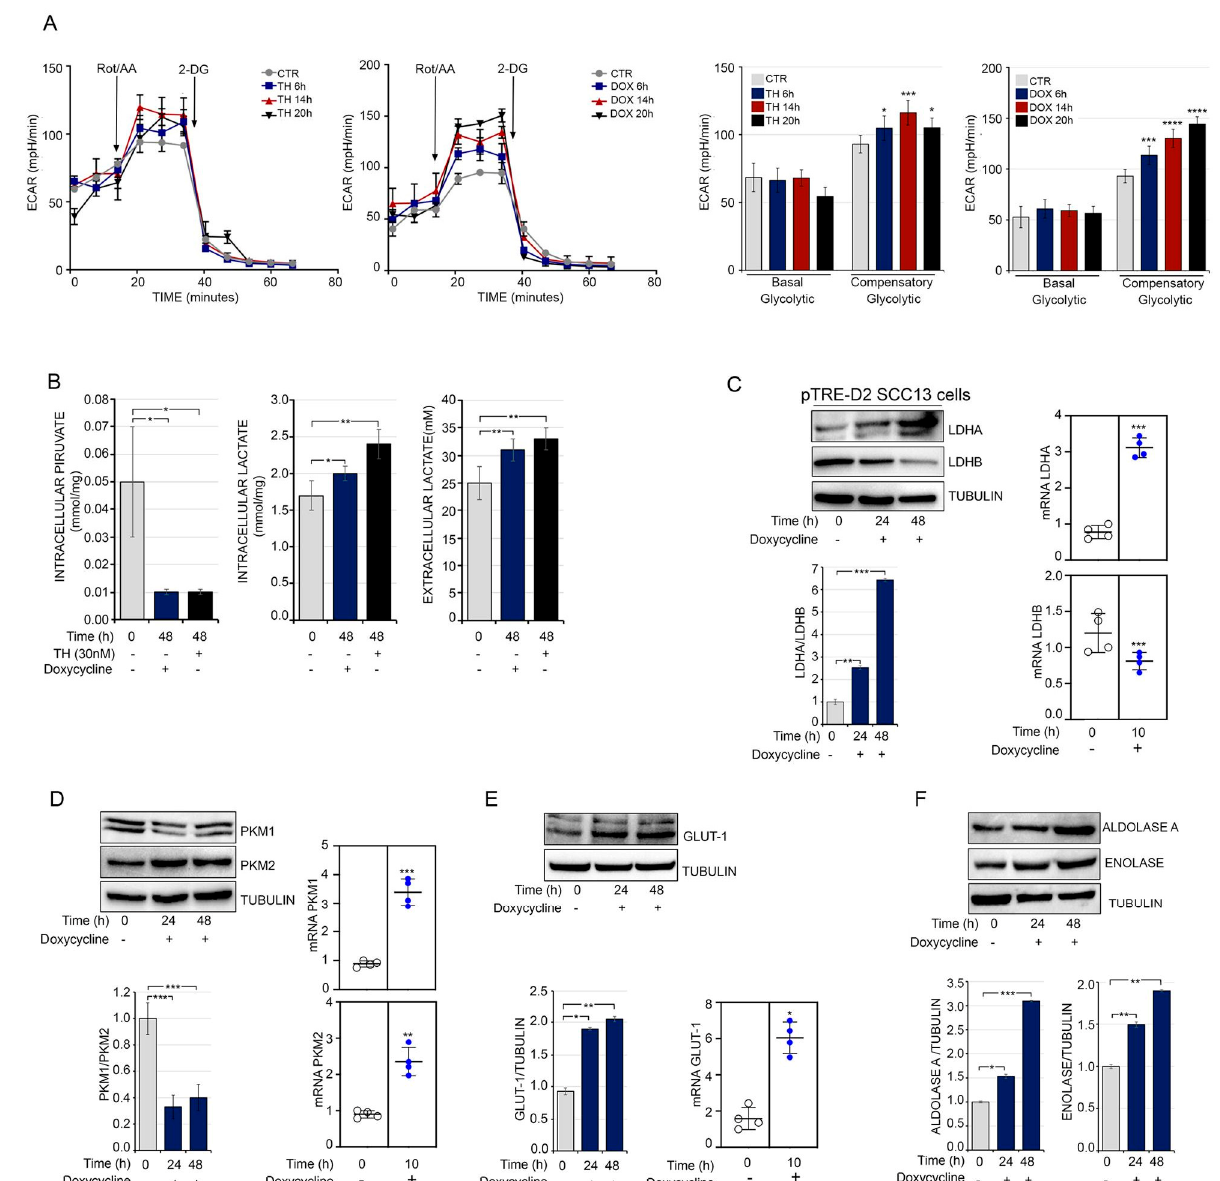
Figure 5. TH drives the metabolic shift in SCC13 cell. ( A ) Assessment of the ECAR showed increased levels of glycolysis in pTRE-D2 SCC13 cells after TH or doxycycline treatment for 6–14–20 h. * p < 0.05, ** p < 0.01, *** p < 0.001, **** p < 0.0001. ( B ) pTRE-D2 SCC13 cells were cultured in complete KSFM and treated with TH and doxycycline for 48 h; lactate and pyruvate concentrations were then measured in cell culture supernatant. Each point represents the mean of the duplicates for each sample and each experiment was done in triplicate. * p < 0.05, ** p < 0.01. ( C ) pTRE-D2 SCC13 cells were treated with doxycycline for 24 and 48 h. Total protein lysates were used for Western blot analysis of LDHA and LDHB. Tubulin expression was measured as loading control ( top ). The LDHA and LDHB ratio is indicated in the diagram (bottom). mRNA levels of LDHA and LDHB in pTRE-D2 SCC13 cells after D2 induction or TH treatment for 10 h (right). ( D ) Western blot analysis of PKM1 and PKM2 was performed in pTRE-D2 SCC13 cells after D2 induction for 24 and 48 h. Tubulin expression was measured as loading control ( top ). The PKM1 and PKM2 ratio is indicated in the diagram (bottom). mRNA levels of PKM1 and PKM2 in pTRE-D2 SCC13 cells after D2 induction or TH treatment for 10 h. ( E ) Expression level of GLUT-1 in pTRE-D2 SCC13 cells after doxycycline treatment by Western blot ( left ) and real-time PCR analysis (right). ( F ) Protein expression level of Aldolase A and Enolase in pTRE-D2 SCC13 cells after doxycycline treatment. Each experiment was performed in triplicates. Results are expressed as the mean ± SD. * p < 0.05, ** p < 0.01, *** p < 0.001.